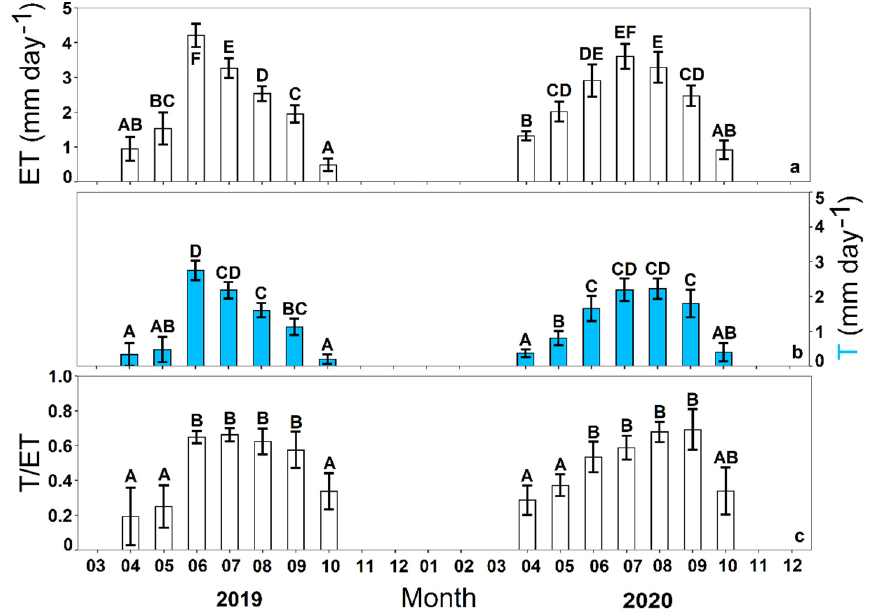
Figure 4. Monthly averages with 95% confidence intervals for ecosystem evapotranspiration ( a ), transpiration ( b ) and transpiration/evapotranspiration ratio ( c ). Distinguishable groups derived from Tukey’s HSD post hoc test are represented by the capital letters.